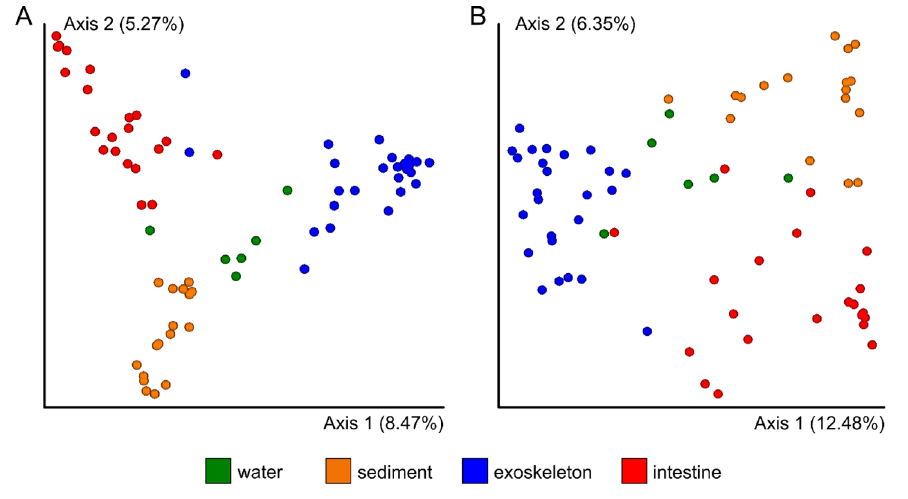
Fig. 2 Beta diversity analyses of mycobiomes between different sample groups. The PcoAs are based on (A) Jaccard and (B) Bray-Curtis distance